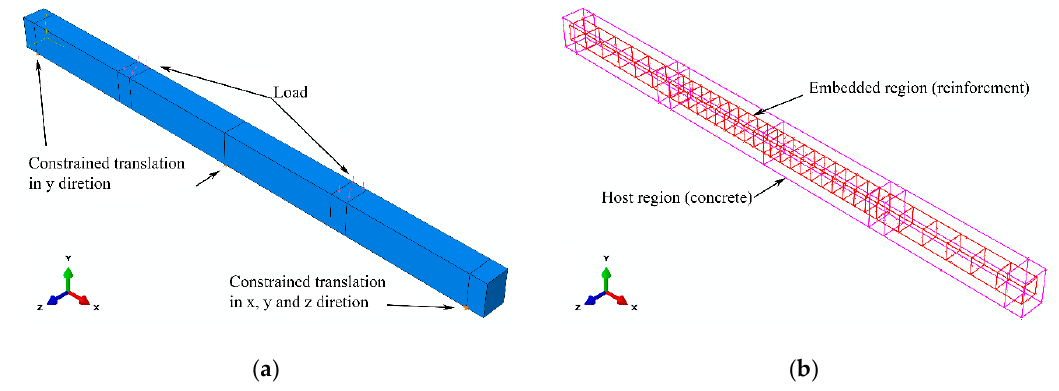
Figure 11. ( a ) Limit conditions and load; ( b ) bond of concrete and reinforcement.